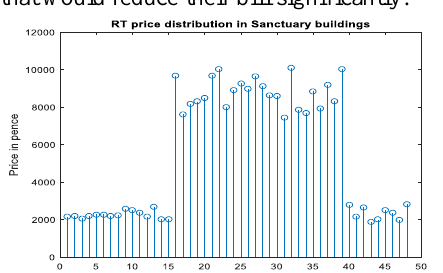
Figure 7. Real time pricing in Sanctuary buildings in SPSA